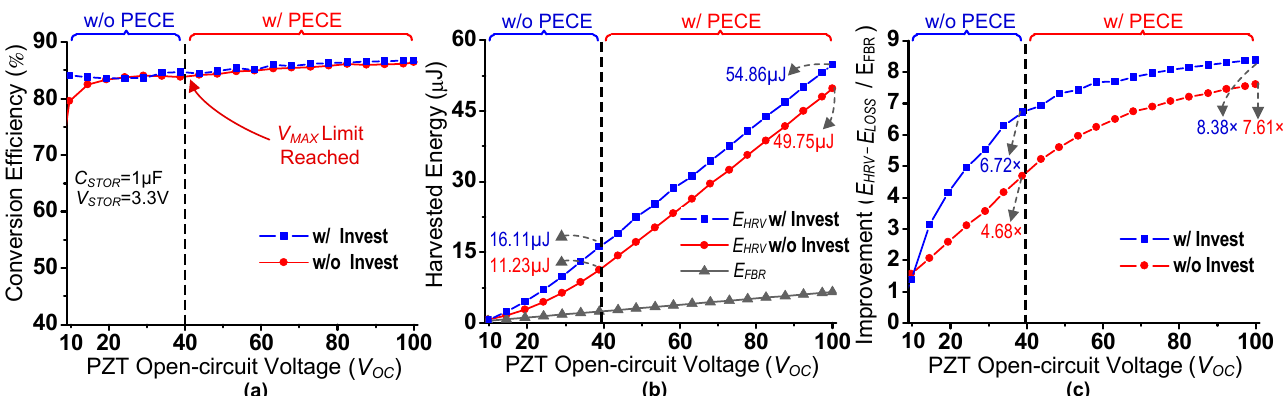
Figure 11. Simulation results of dual-PZT energy-harvesting circuit for different V OC s. ( a ) Harvesting circuit conversion efficiency. ( b ) Proposed circuit harvested energy (w/ and w/o energy investment) comparison with FBR-based harvester. ( c ) Energy extraction improvement compared to FBR-based harvester.